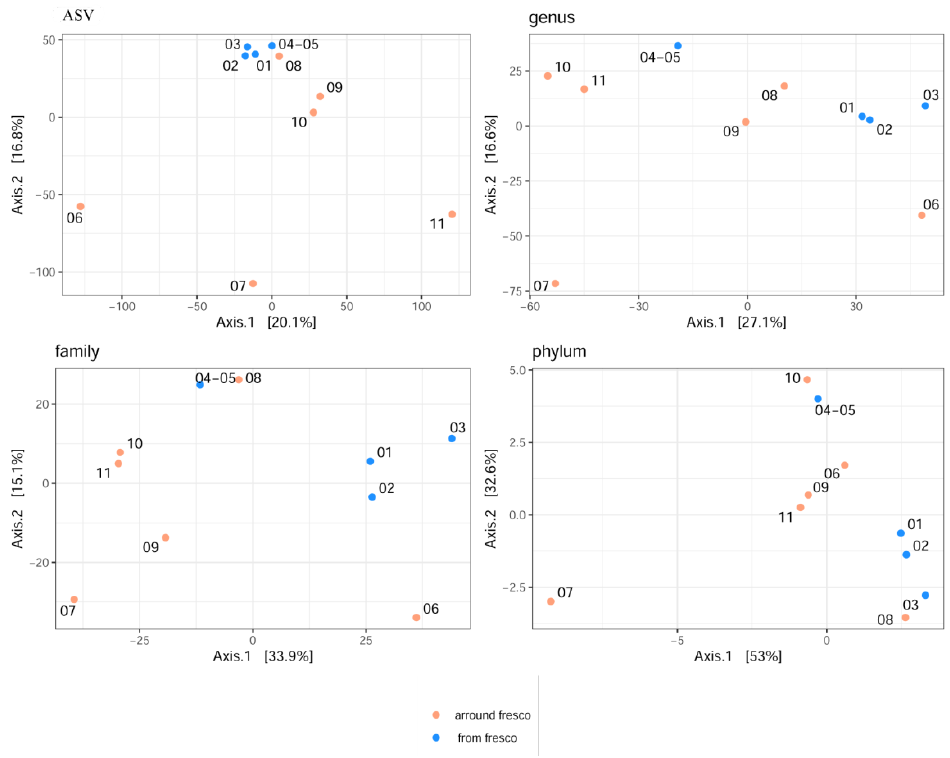
Figure 8. The MDS (PCoA) plot created with Euclidean distances at the phylum, family, genus, and ASV taxa levels, showing the variability between samples.